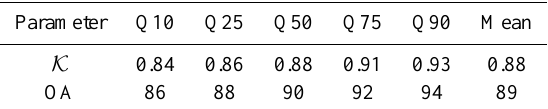
Figure 6. Evolution of K [–] as a function of the training set size. The solid red line indicates the median, while the blue and brown areas represent Q75–25 and Q90–10, respectively. The size of the training set was varied with a step of 1 between 300 and 20. Statis- tics are based on 200 realizations. Table 3. Mean values and relevant quantiles of K [–] and OA [%] calculated over 200 iterations of the SVM validation